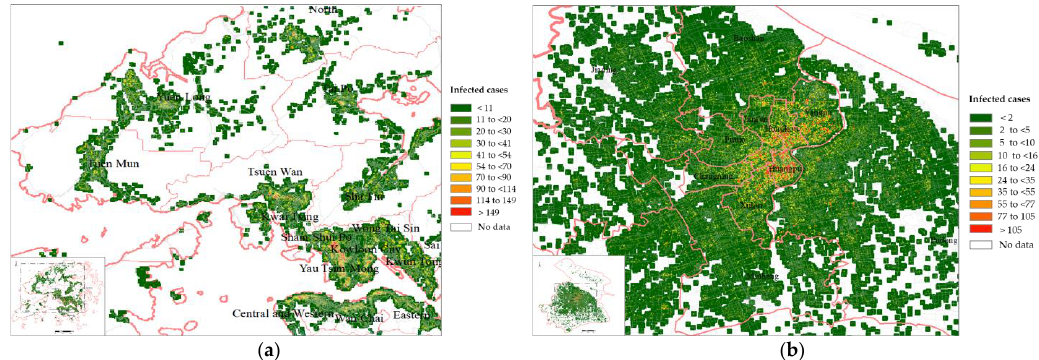
Figure 2. Distribution of confirmed COVID-19 cases in ( a ) Hong Kong and ( b ) Shanghai.